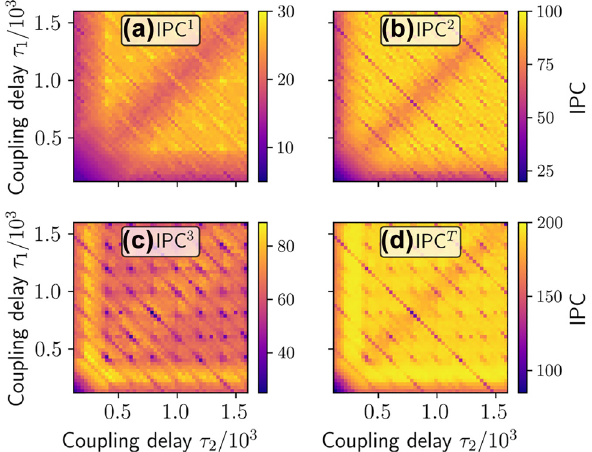
Figure 3: Information processing capacities: (a) IPC 1 , (b) IPC 2 , (c) IPC 3 and (d) IPC T , as defined in Eq. (8), plotted colour coded as a and 𝜏 in the ring-coupled system Eq. (9) with two function of 𝜏 1 2 oscillators. Pearson correlation coefficients between the IPCs and the task NMSEs shown in Figure 4 are given in Table 2.